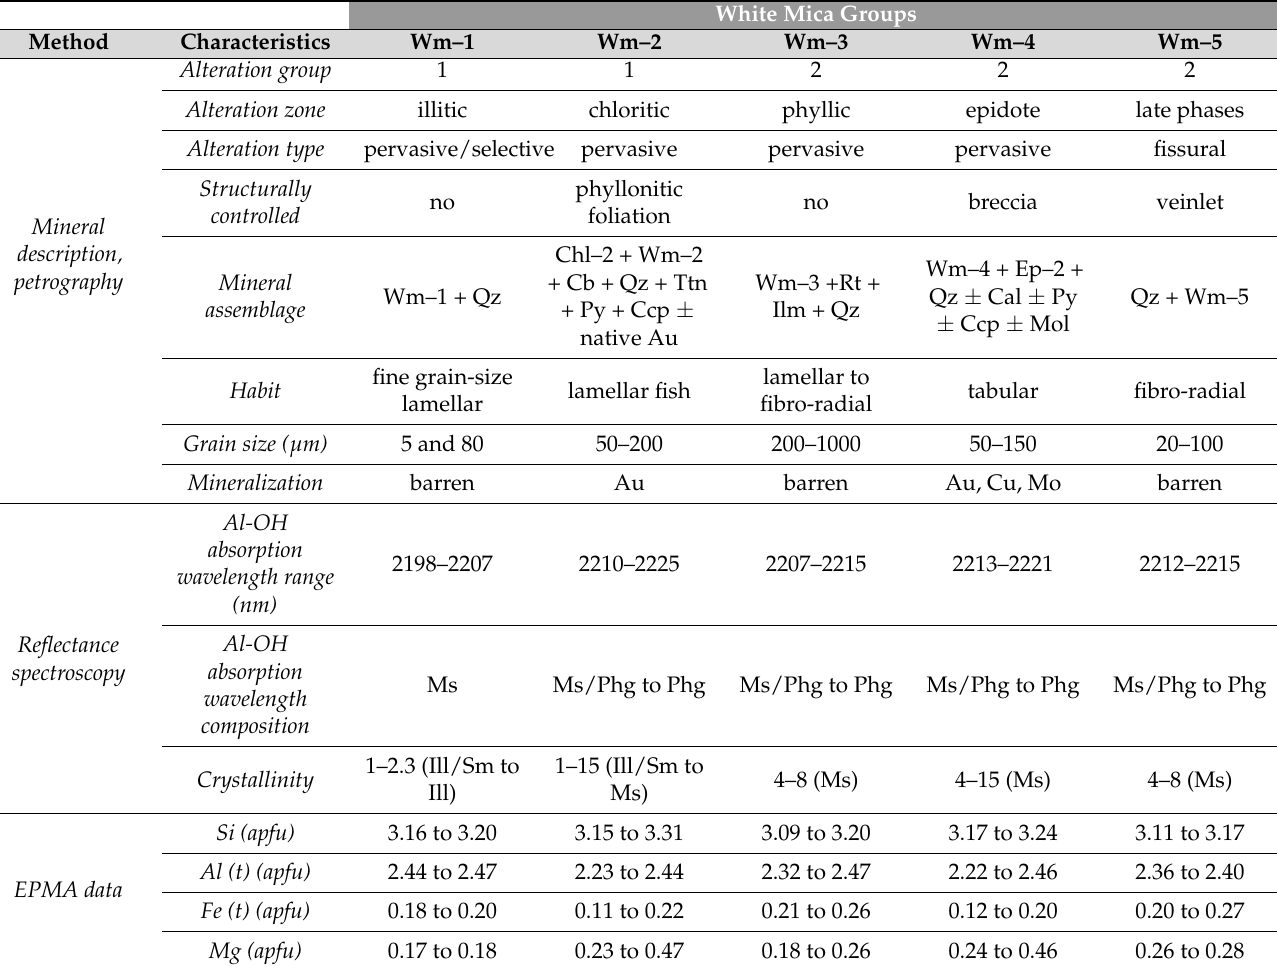
Table 1. Summary of the five groups of white mica described in the Para í ba deposit, based on the mineral characteristics, drill-core logging, petrography, reflectance spectroscopy, and EMPA-derived data based on 11 oxygens. In Figure 4, Wm–1 in samples BH059-009; Wm–2 in samples BH020-019 and BH020-027; Wm–3 in samples BH041-003 and BH059-009; Wm–4 in sample BH041-012; and Wm–5 in sample